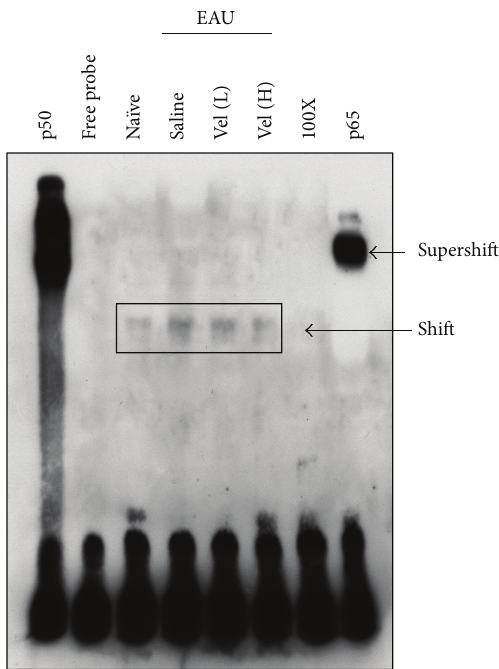
Figure 4: EMSA for the evaluation of the NF- 𝜅 B DNA-binding activity in na¨ıve mice and different groups of EAU mice. Lane 1 : p50 subunit of NF- 𝜅 B. Lane 2 : free probe (FP). Lane 3 : na¨ıve C57BL/6 mice. Lane 4 : EAU mice with saline treatment. Lane 5 : EAU mice treated with low-dose bortezomib (Vel [L]). Lane 6 : EAU mice treated with high-dose bortezomib (Vel [H]). Lane 7 : 100-fold molar excessofunlabeledNF- 𝜅 Bprobe. Lane8 :anti-p65subunitofNF- 𝜅 B. The sample was pooled from both eyes of five mice in each group. Data are representative of results in three independent